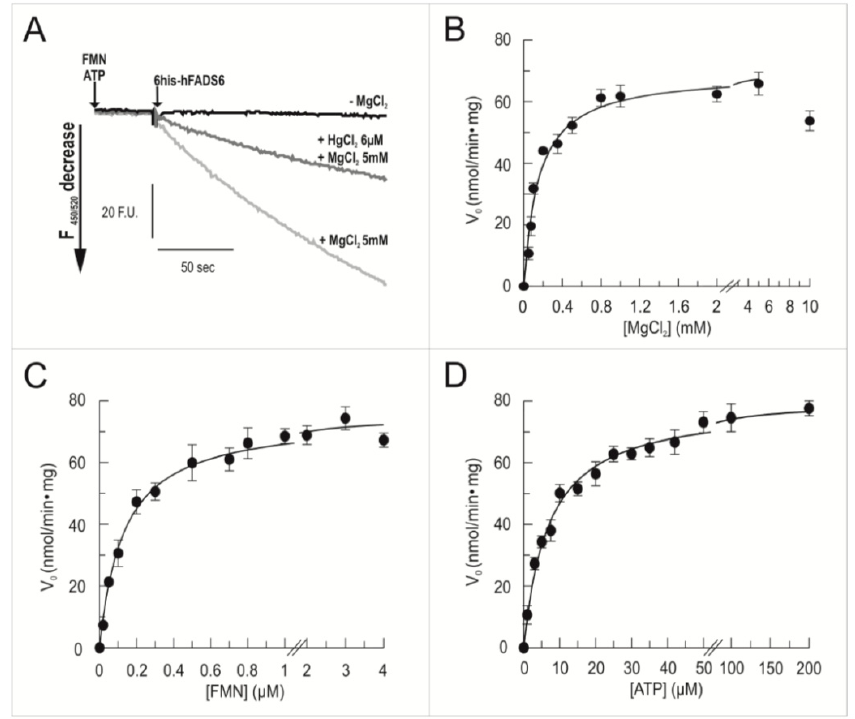
Figure 5. Fluorimetric evidence of FAD synthesis. ( A ) FAD synthesis was followed in 2 mL of 50 mM Tris/HCl, pH 7.5, containing 2 µM FMN and 100 µM ATP, at 37 °C, in the absence of MgCl 2 (black line) and in the presence of 5 mM MgCl 2 (light grey) or in the presence of 5 mM of MgCl 2 plus 6 µM HgCl 2 (dark grey). The FAD synthesis reaction was started by the addition of 6His-hFADS6 (0.11 µM) and measured by the initial rate of fluorescence decrease ( λ excitation = 450 nm, λ emission = 520 nm); ( B ) MgCl 2 concentration dependence. FAD synthesis rate, catalyzed by purified 6His-hFADS6 (0.13 µM), was measured fluorimetrically at 37 °C in 2 mL of 50 mM Tris/HCl pH 7.5, in the presence of 100 µM ATP, 2 µM FMN, and of the given MgCl 2 concentrations; ( C )